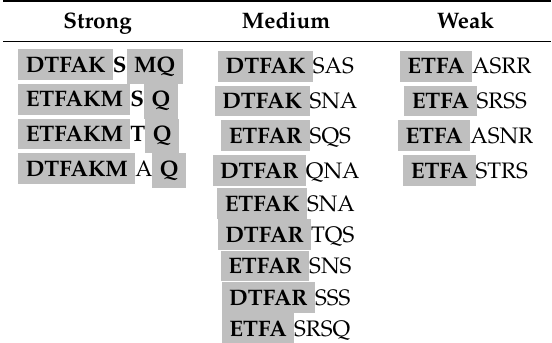
Table 1. Families of β -Galactosidase-binding phages grouped by relative a ffi